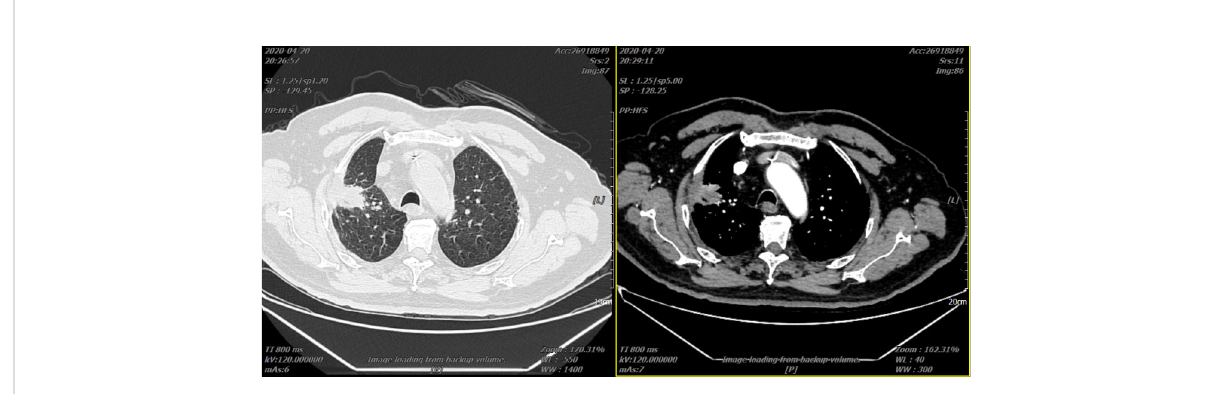
FIGURE 4 Two representative CTs of the patient on 20 April